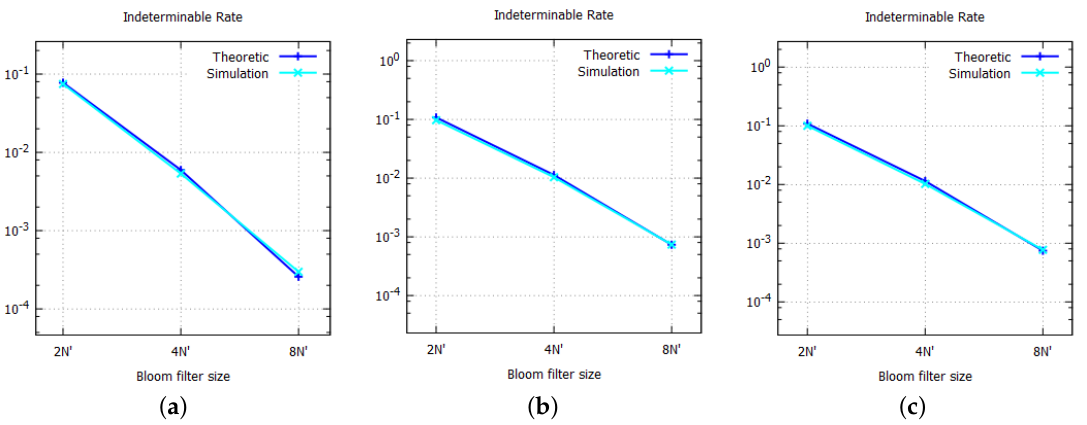
Figure 6. Comparison of indeterminable rate for p -BF: ( a ) 10k; ( b ) 50k; ( c ) 100k.